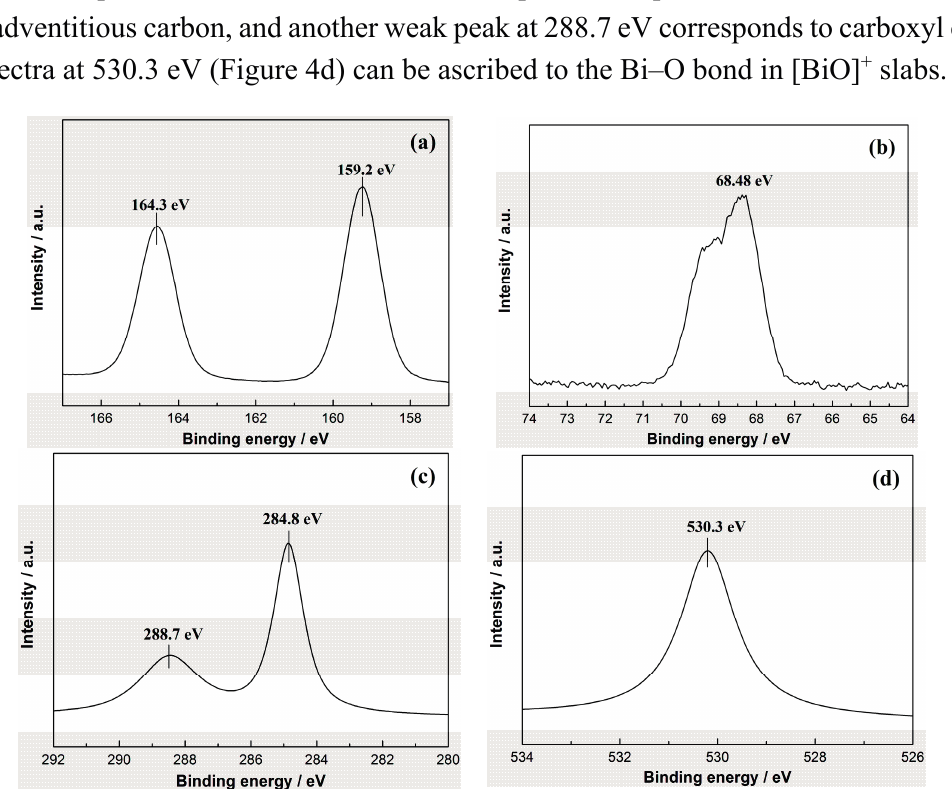
Figure 4 The XPS spectra of BHB-0.25, Bi4f ( a ); Br ( b ); C1s ( c ) and O1s ( d